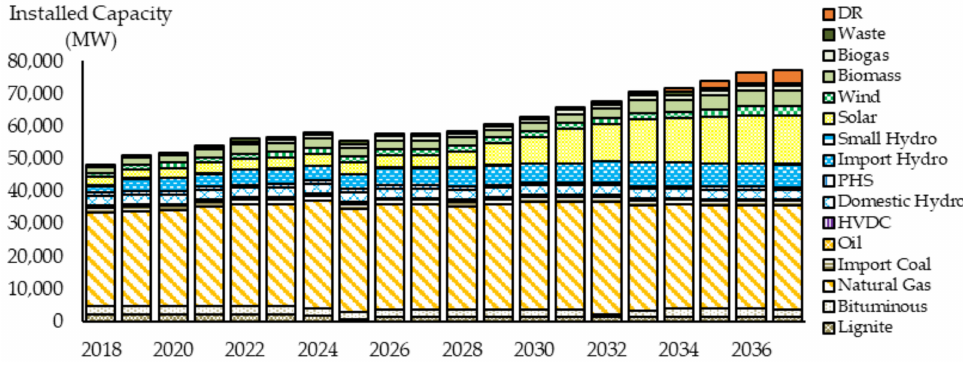
Figure 7. Capacity mix of PDP2018r1.